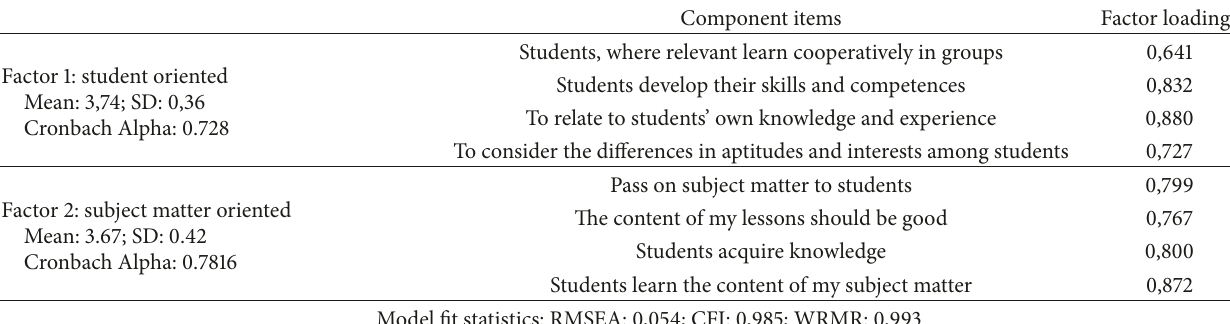
Table 6: Degree of agreement on collective teacher efficacy (1 = not at all; 7 = fully agree ) ∗ .